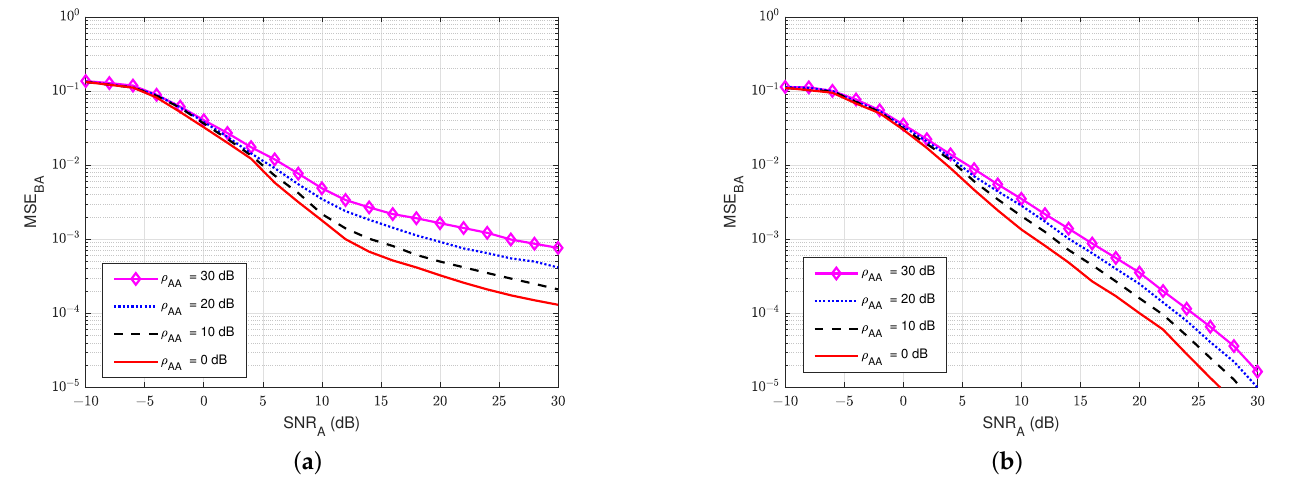
Figure 8. MSE BA versus SNR A in case of passive eavesdropper: ( a ) Blind without feedback; ( b ) Blind